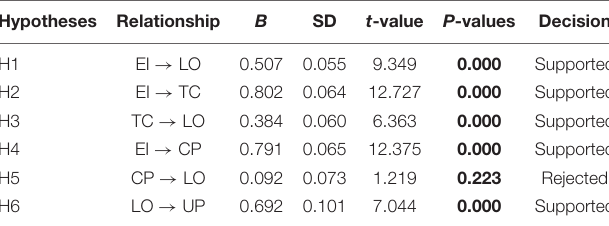
TABLE 5 | Results of structural model path coefficient (direct